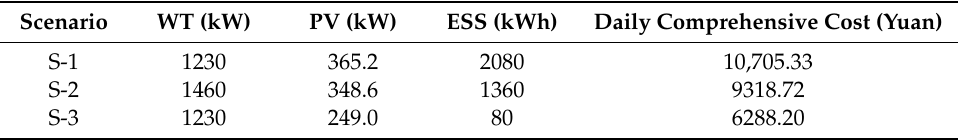
Table 5. DGs and ESS planning results.